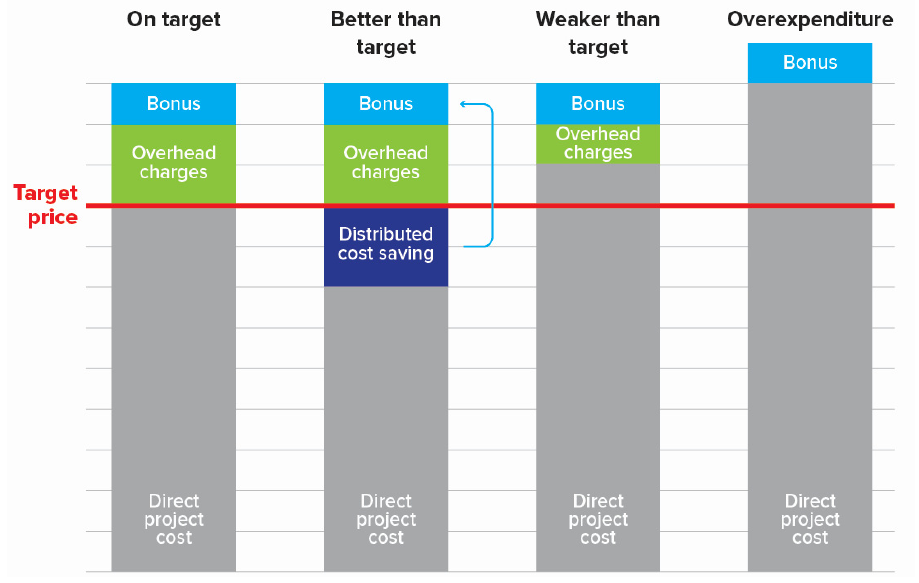
Figure 3. Remuneration model of Norwegian Integrated Project Delivery Model, reproduced [41].